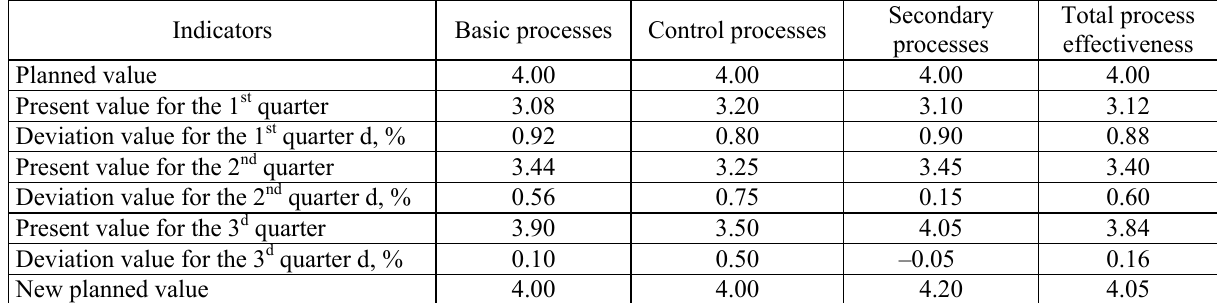
Table 2. Effectiveness of the process "Activities for the production of boiled sausages"